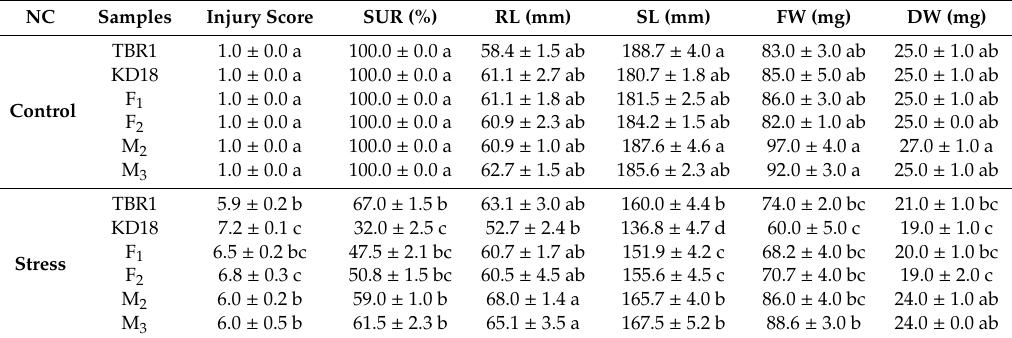
Table 1. Phenotypic responses of examined rice in salinity